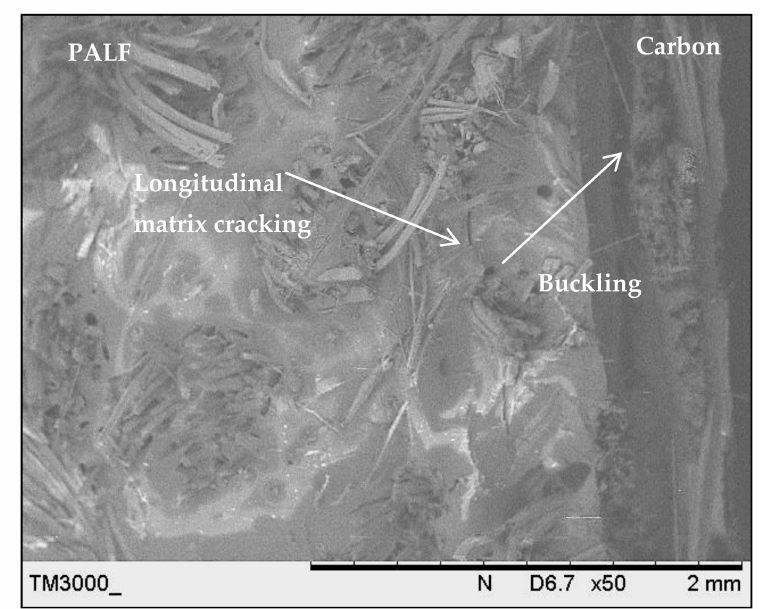
Figure 15. Scanning electron microscopy image of the laminate with a carbon ply exterior (CPPC) and ply orientation [0 ◦ , 90 ◦